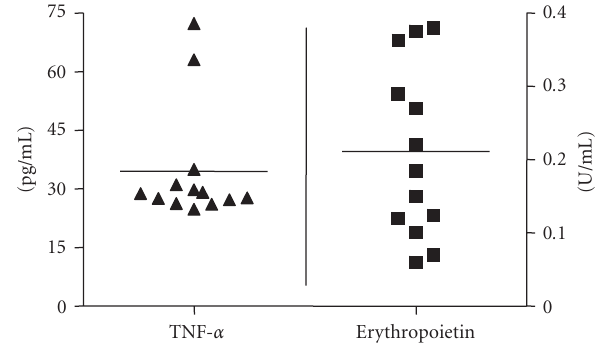
Table 1: Patient characteristics of the study group. FEV 1 = forced expiratory flow in 1 second, FEV 1 / VC = Ti ff eneau index, pO 2 = par-